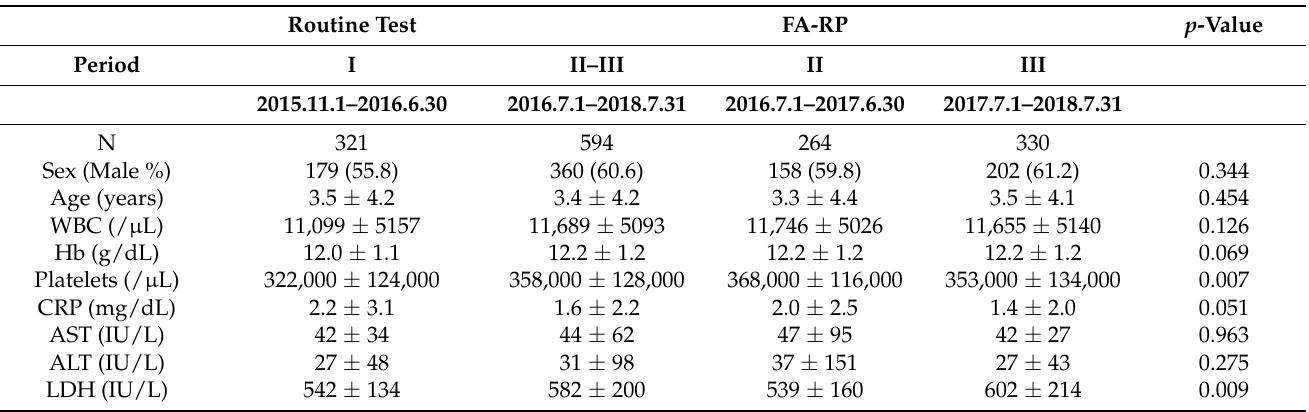
Figure 1. Patient enrollment flowchart. Table 1. Baseline characteristics of